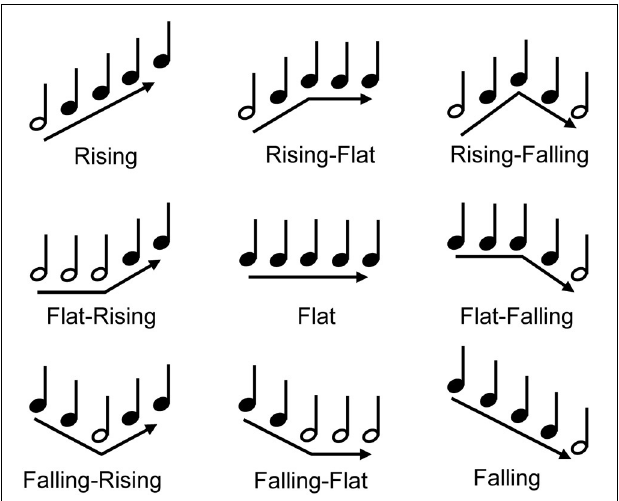
FIGURE 7 | The nine melodic contours used for MCI testing. The white note shows the lowest note of the contour (A3; 220Hz).